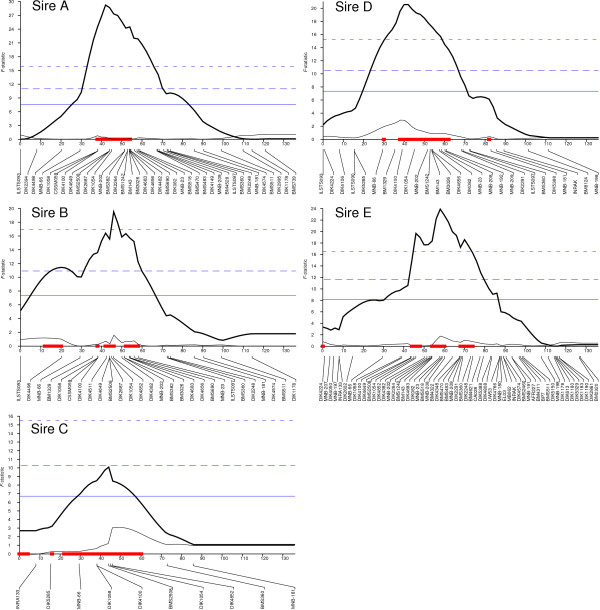
F-statistic profiles for carcass or body weight (Sire C only) on BTA 6. Marker locations were obtained from the Shirakawa-USDA linkage map [20]. Bold and thin lines indicate a fixed-effect QTL model and a fixed-effect QTL model accounting for the effect of SNP-9 of NCAPG, respectively. The boxes on the x-axis indicate the 95% CI of the QTL. The horizontal lines indicate the thresholds for chromosome-wise 0.1% (- - -), 1% (- -), and 5% (---) significance levels.